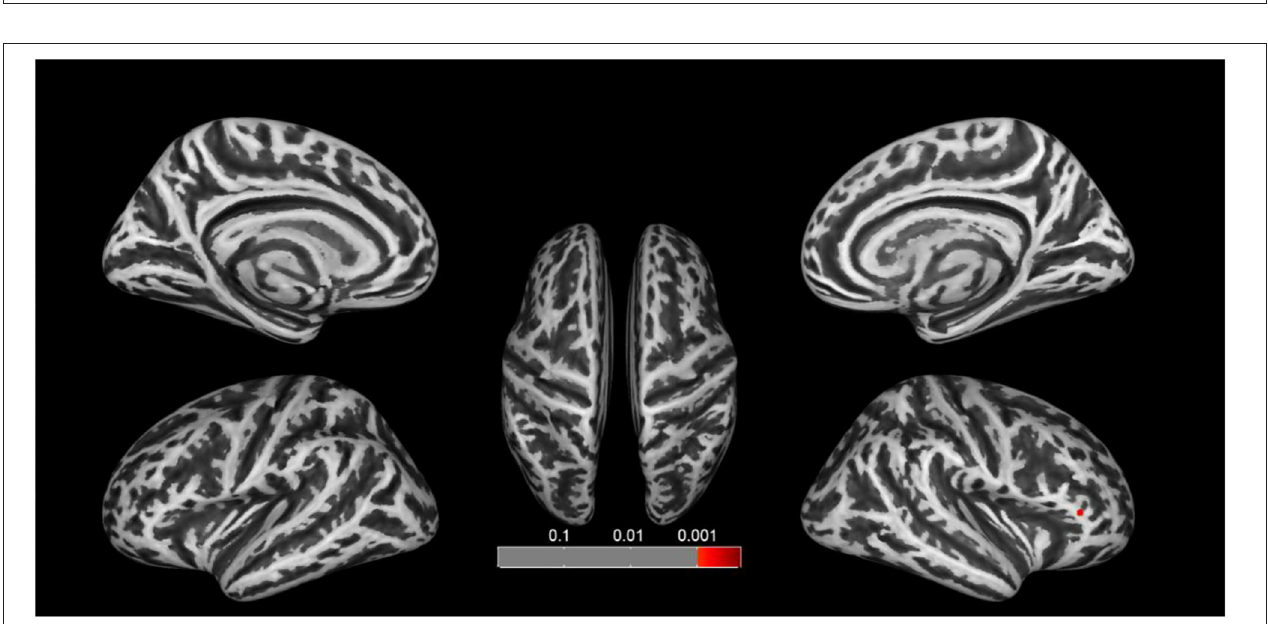
FIGURE 3 | Clusters that significantly varied in terms of fractal dimension in the CA group vs. the HC group. The congenital amusia group had a significantly higher fractal dimension value in the right caudal middle frontal gyrus compared to healthy controls ( p < 0.05; false discovery rate-corrected at the cluster level).